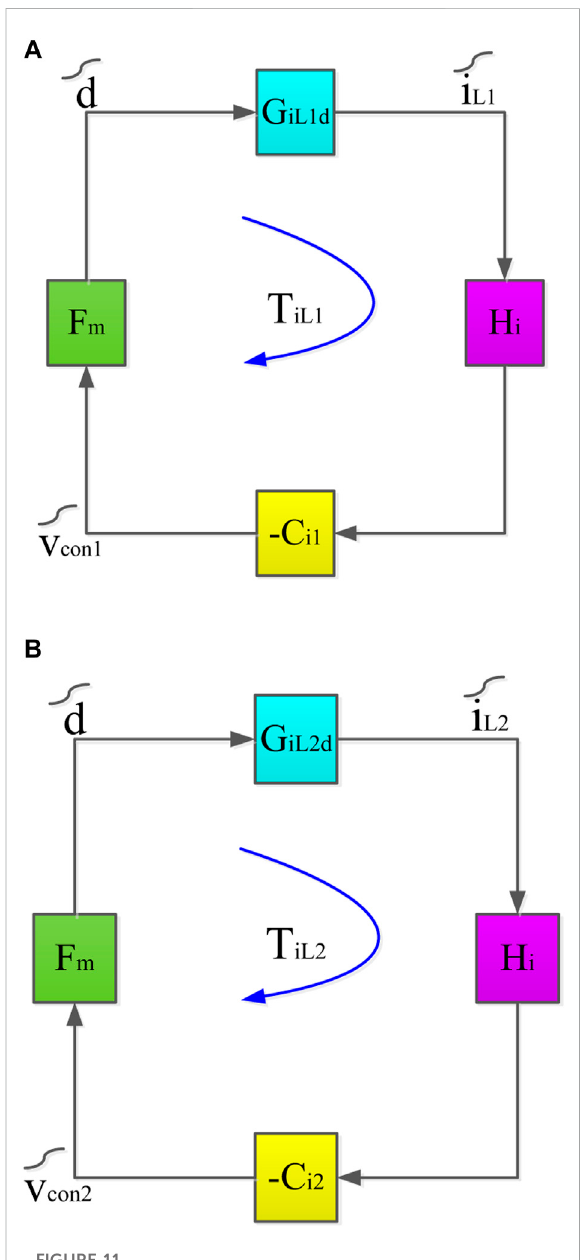
FIGURE 11 Diagrams demonstrating a closed-loop control method for (A) the energy from an energy-regenerating high-voltage dc-link mode and (B) the Dual-source low-voltage powering